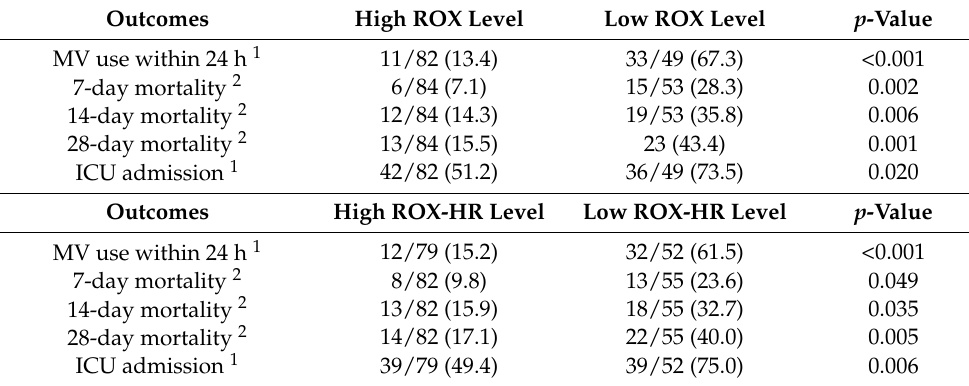
Table 2. Outcomes according to the ROX index level and ROX-HR index